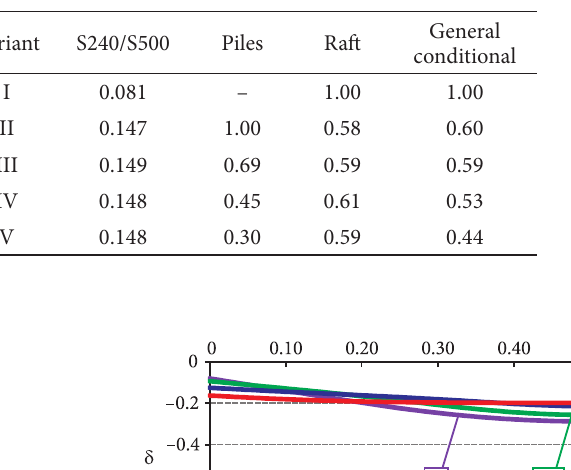
table 7. Qualitative (S240/S500) and quantitative relative reinforcement expenses